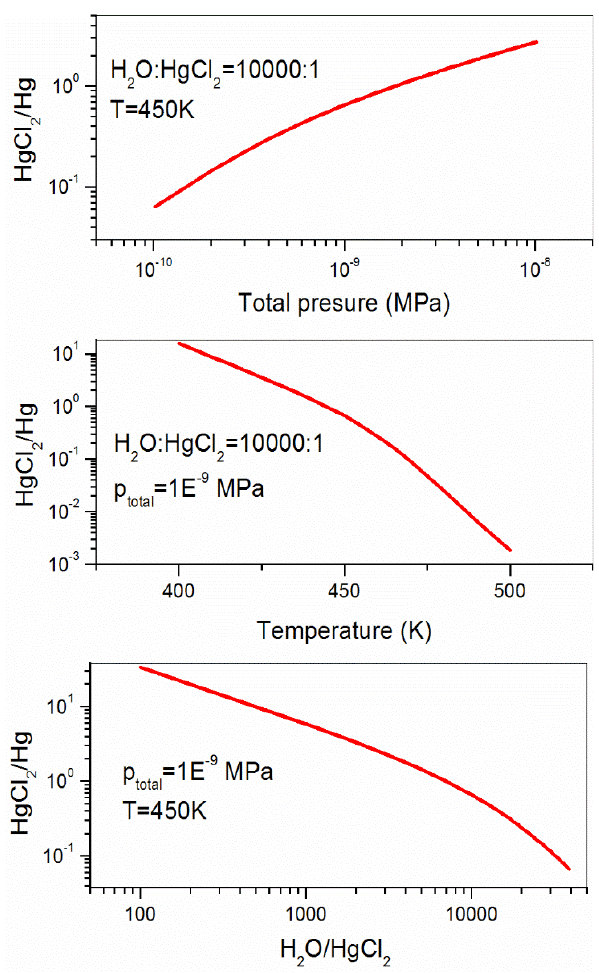
vapours in equilibrium with 2 at 20 °C. 2